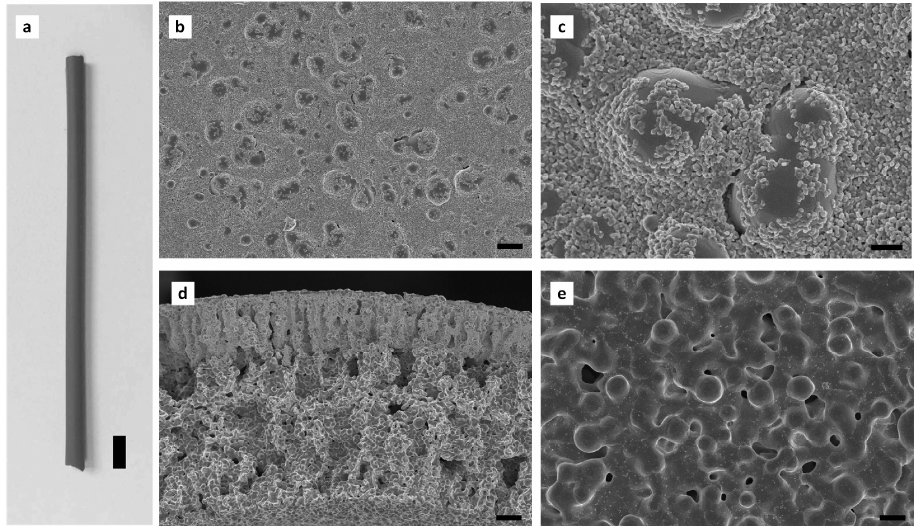
Figure 3. ( a ) Photo of a dual-layer stainless steel (SS)/SS–yttria-stablilised ZrO 2 (YSZ) hollow fibre. SEM measurements for the SS/SS-YSZ hollow fibres: ( b , c ) outer surface ( d ) cross-section, and ( e ) inner surface. (Scale bars: ( a ) 5 mm, ( b ) 4 µm, ( c ) 1 µm, ( d ) 20 µm, ( e ) 4 µm). Reprinted from “High performance stainless steel-ceramic composite hollow fibres for microfiltration” [89].